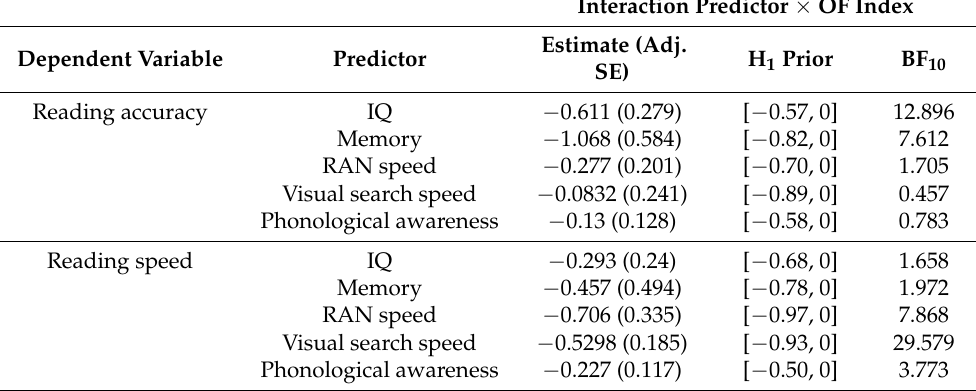
Interaction Predictor × OF Index Estimate (Adj. H 1 Prior BF 10 SE)